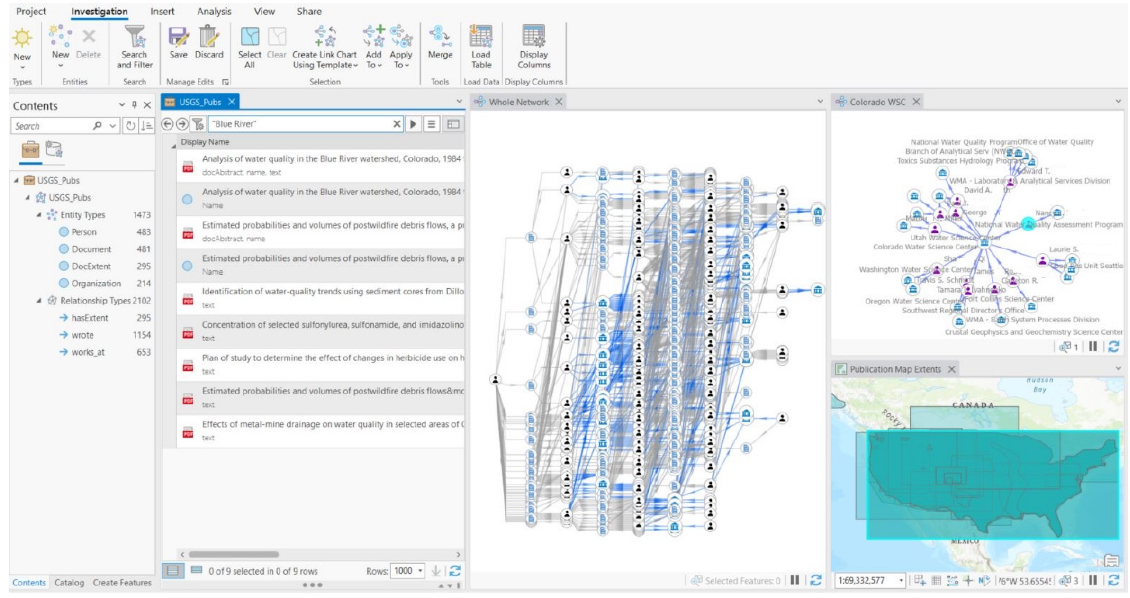
Figure 1. Determining where expertise is through a citation search at the US Geological